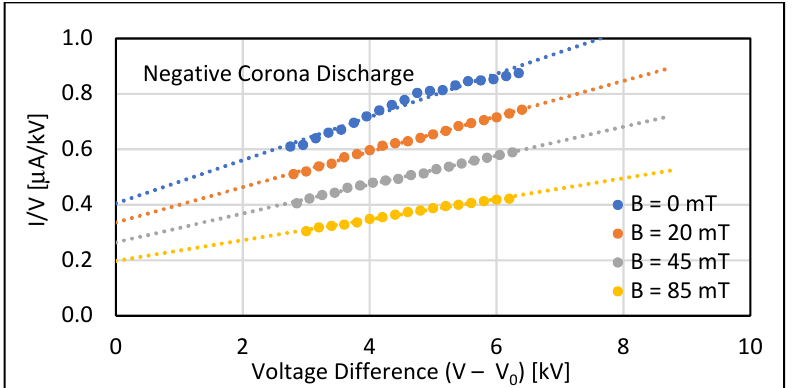
Figure 10. The dependence of I/V versus voltage difference (V − V 0 ) for negative corona at various magnetic field B.